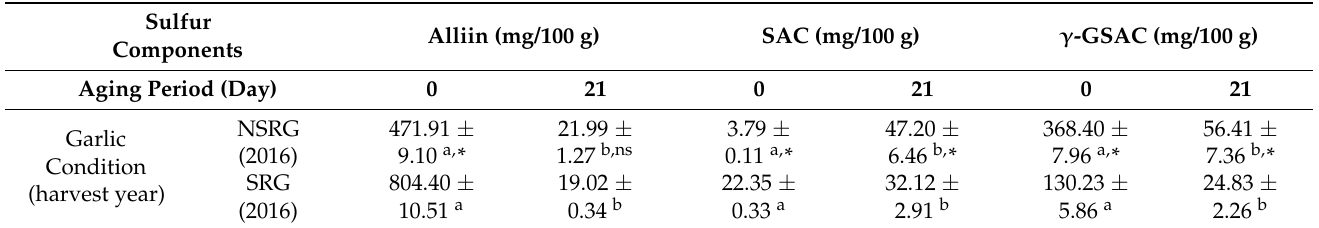
SRG and NSRG harvested in 2016 were aged for 21 days at 40~86 ◦ C in the same manner. SAC, S-allyl cysteine; γ -GSAC, γ -glutamyl-S-allyl-L-cysteine; NSRG, non-stored raw garlic; SRG, stored raw garlic. The data are presented as the mean ± standard deviation (SD). Lowercase letters indicate significant differences between the same sample based on Duncan’s multiple range test ( p < 0.05). The asterisk (*) symbol indicates a significant difference between SRG and NSRG of the same aging date. The ns indicates no significant difference between SRG and NSRG of the same aging